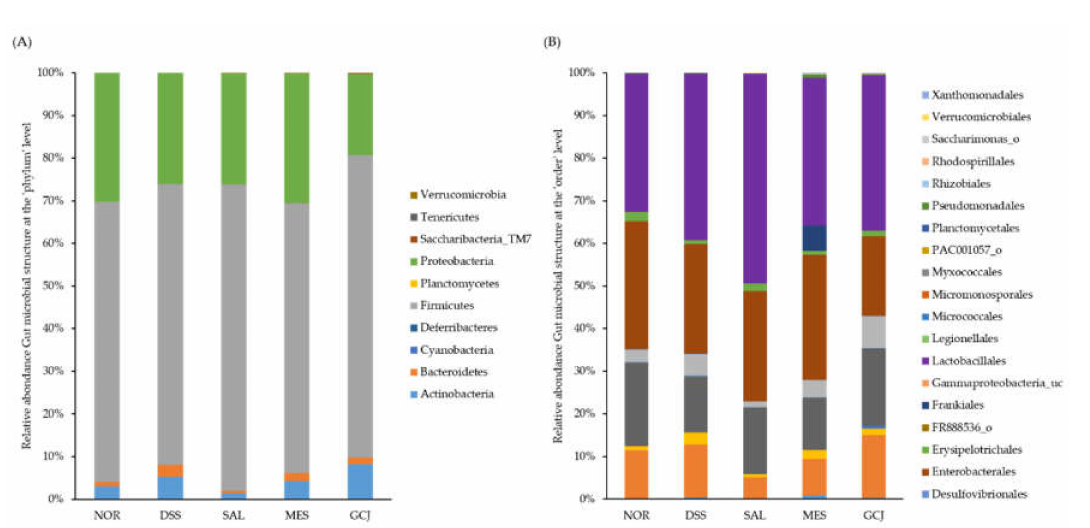
Figure 4. Effects of Gochujang on relative abundances of gut microbiota in DSS-treated rats at ( A ) phylum level and ( B ) order level ( n = 7 per group). Table 4. Effects of Gochujang on relative abundances of gut microbiota at species level in DSS-treated rats.